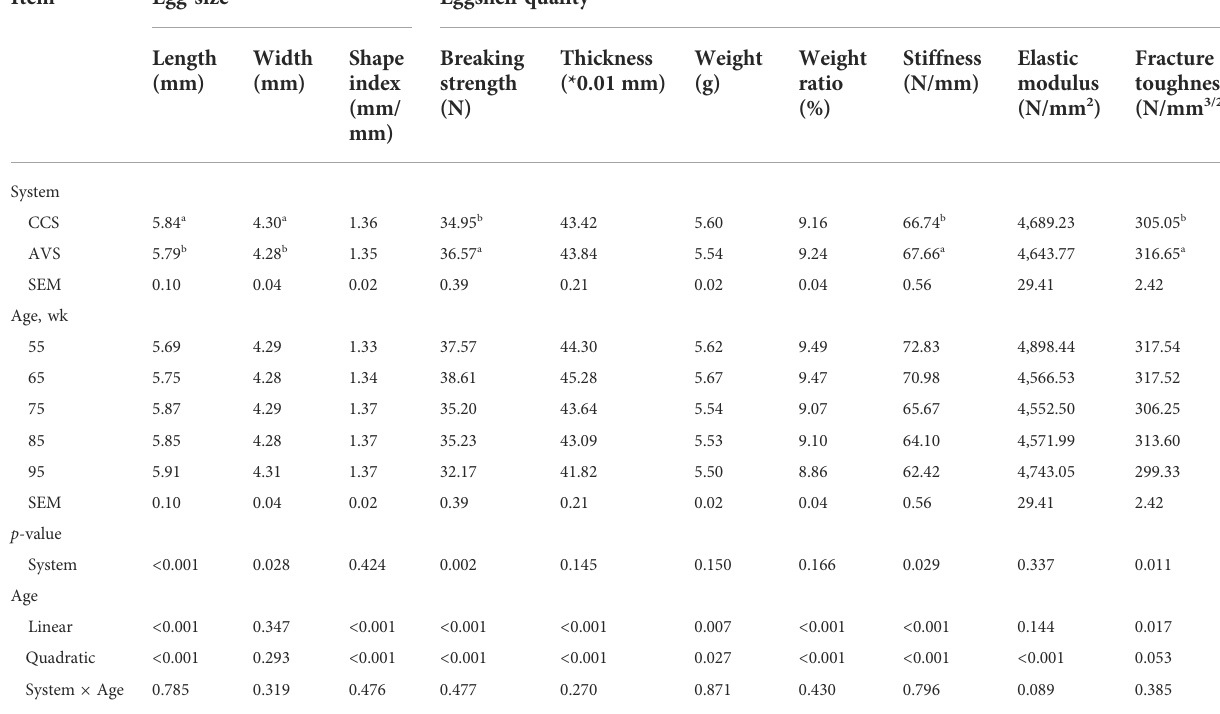
TABLE 2 Effect of rearing systems on eggshell quality of laying hens (55 – 95 weeks of age) a